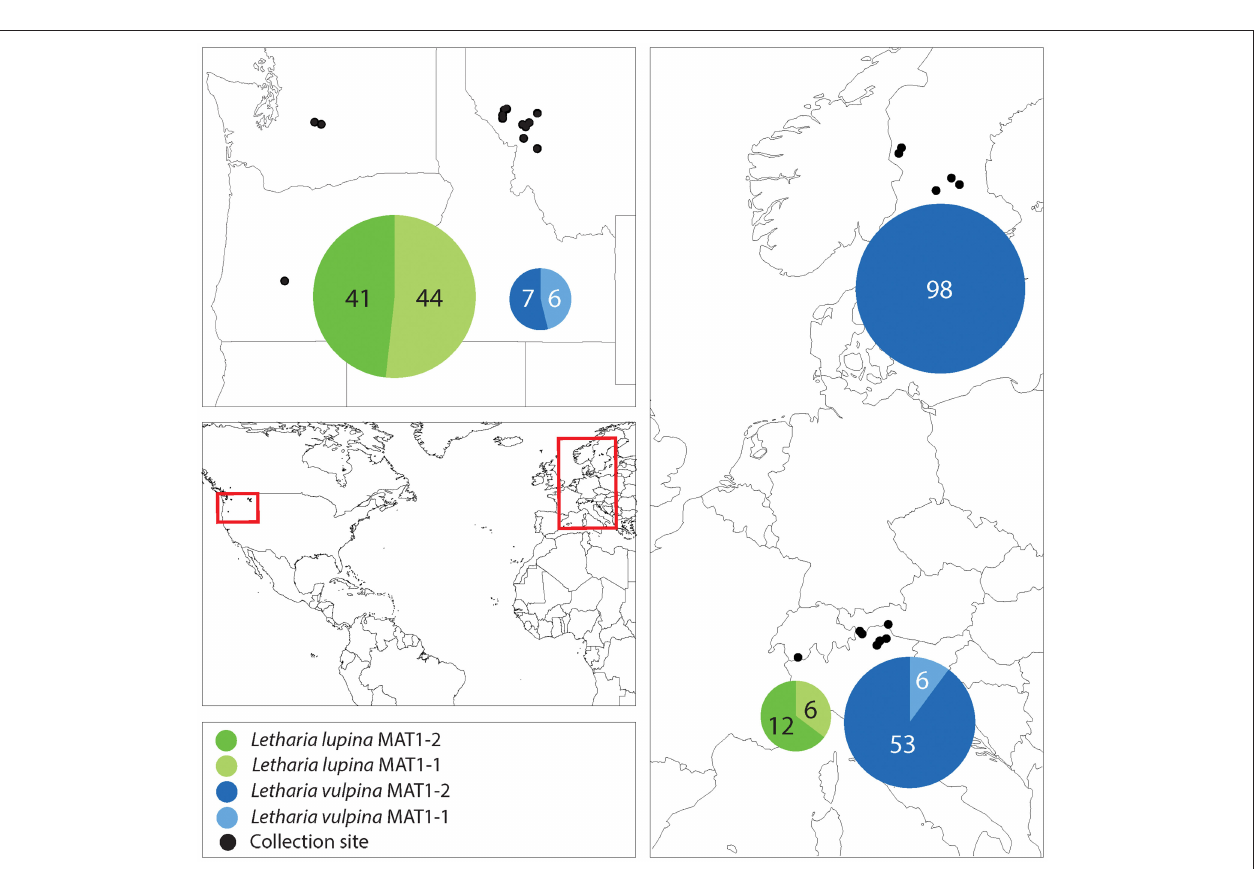
FIGURE 7 | A map showing the collection sites and mating-type distribution in the sorediate species in the U.S.A., the Swiss and Italian Alps and Sweden. The numbers correspond to the number of sampled thalli (n), and the areas of the pie charts are proportional to n.